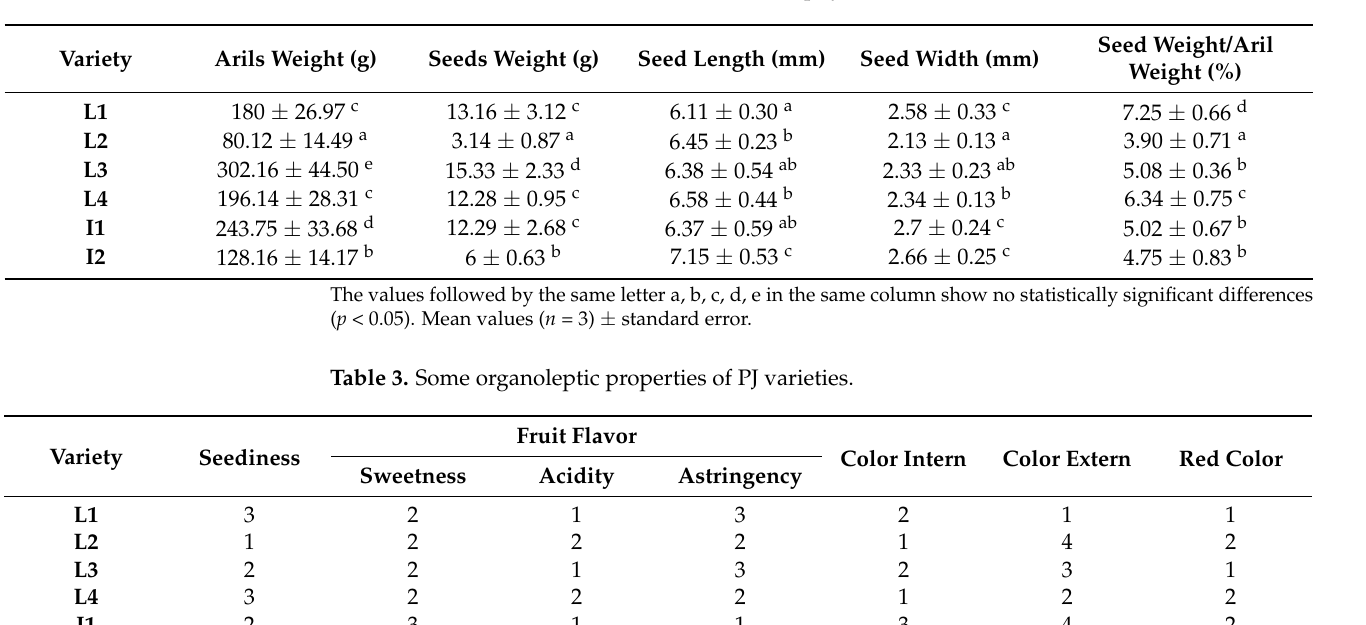
Table 2. Mean ( n = 15) values of seeds and arils physical characteristics.